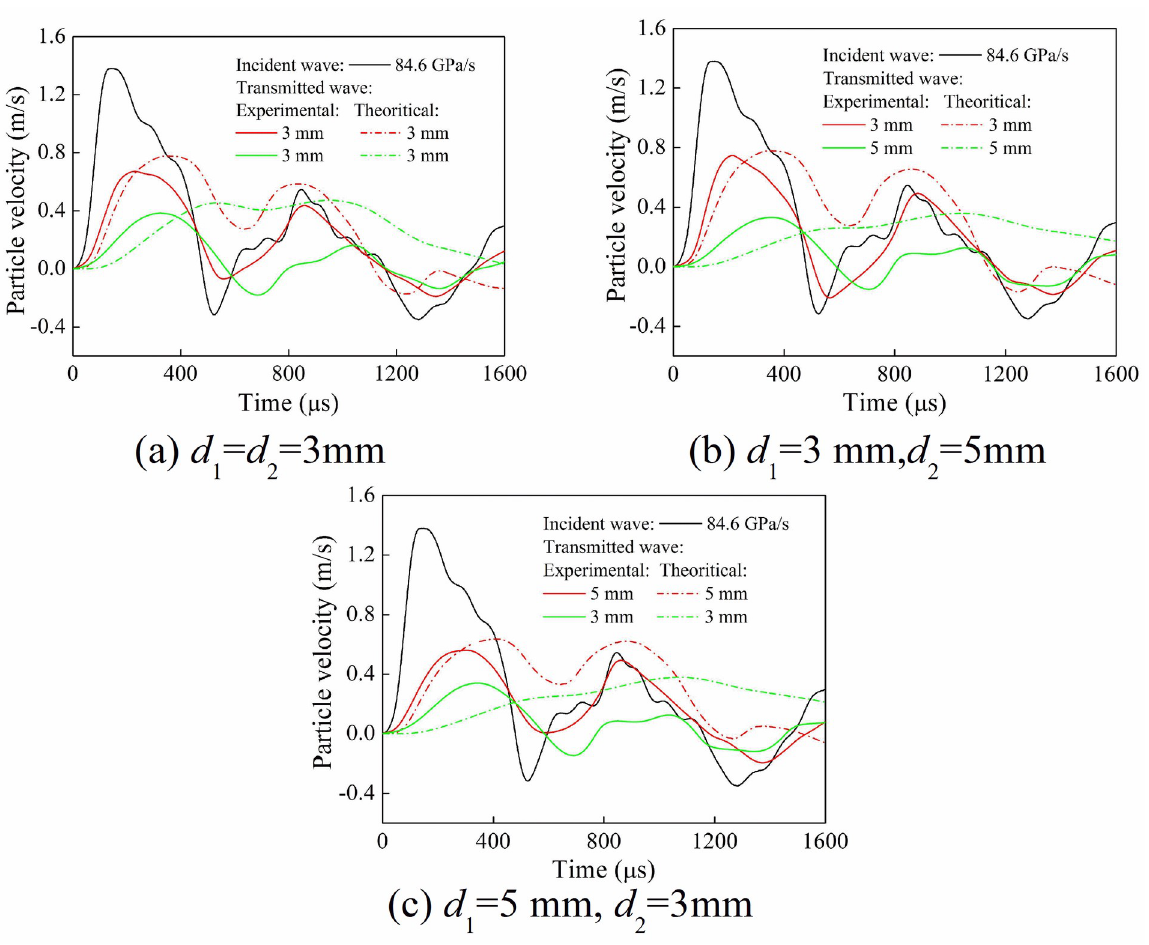
Fig 20. Time-history curves of particle velocity of transmitted waves (quartz sand). (a) d 1 = d 2 = 3 mm (b) d 1 = 3 mm, d 2 = 5 mm (c) d 1 = 5 mm, d 2 = 3